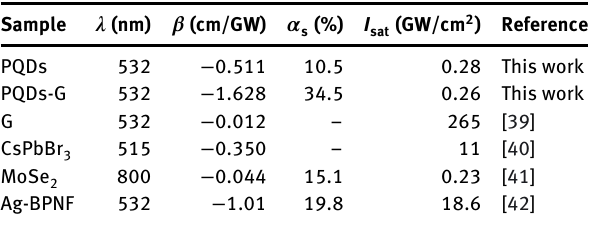
Table 2: Nonlinear absorption parameters of different materials.